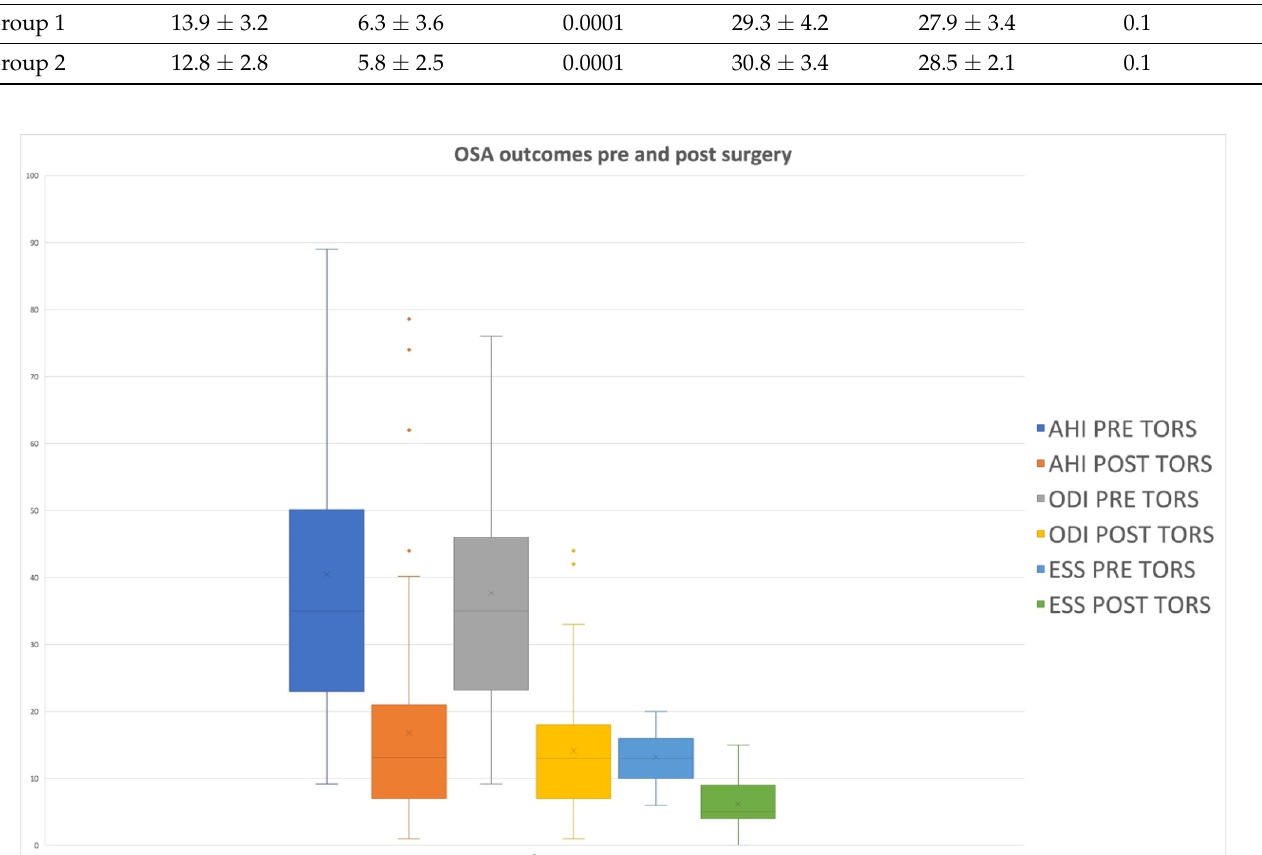
Figure 1. box plot showing differences in OSA outcomes pre- and post TORS in a multilevel setting. Figure 1. Box plot showing differences in OSA outcomes pre- and post TORS in a multilevel